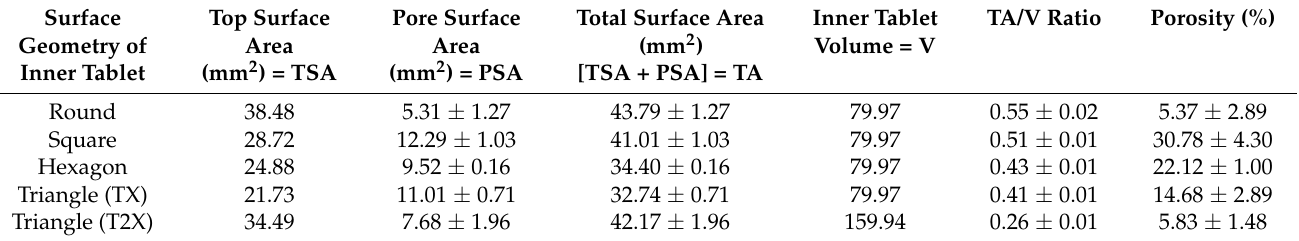
Figure 5. PXRD patterns of PVA, FDP, physical mixtures of FDP and PVA, and FDP-loaded PVA filaments. Table 2. Porosity and pore surface area of inner compartments of FDP-loaded 3D-printed tablets using